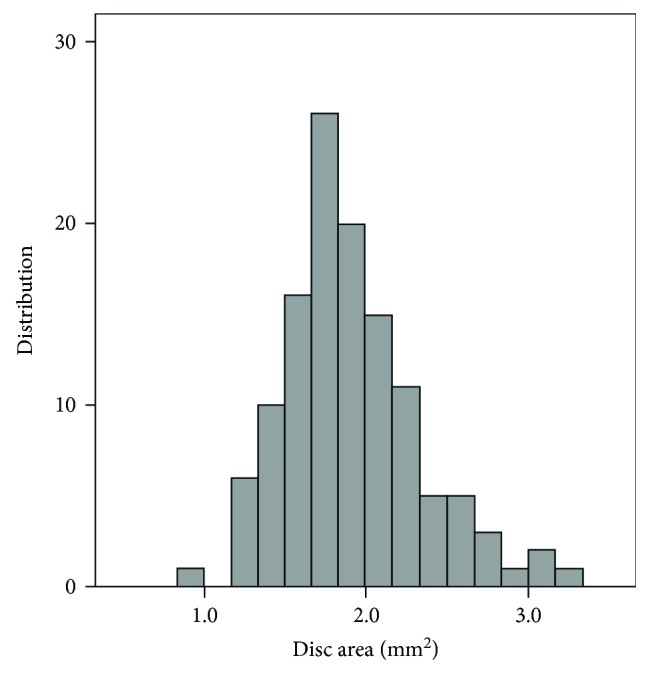
Distribution of optic disc size in the entire cohort.